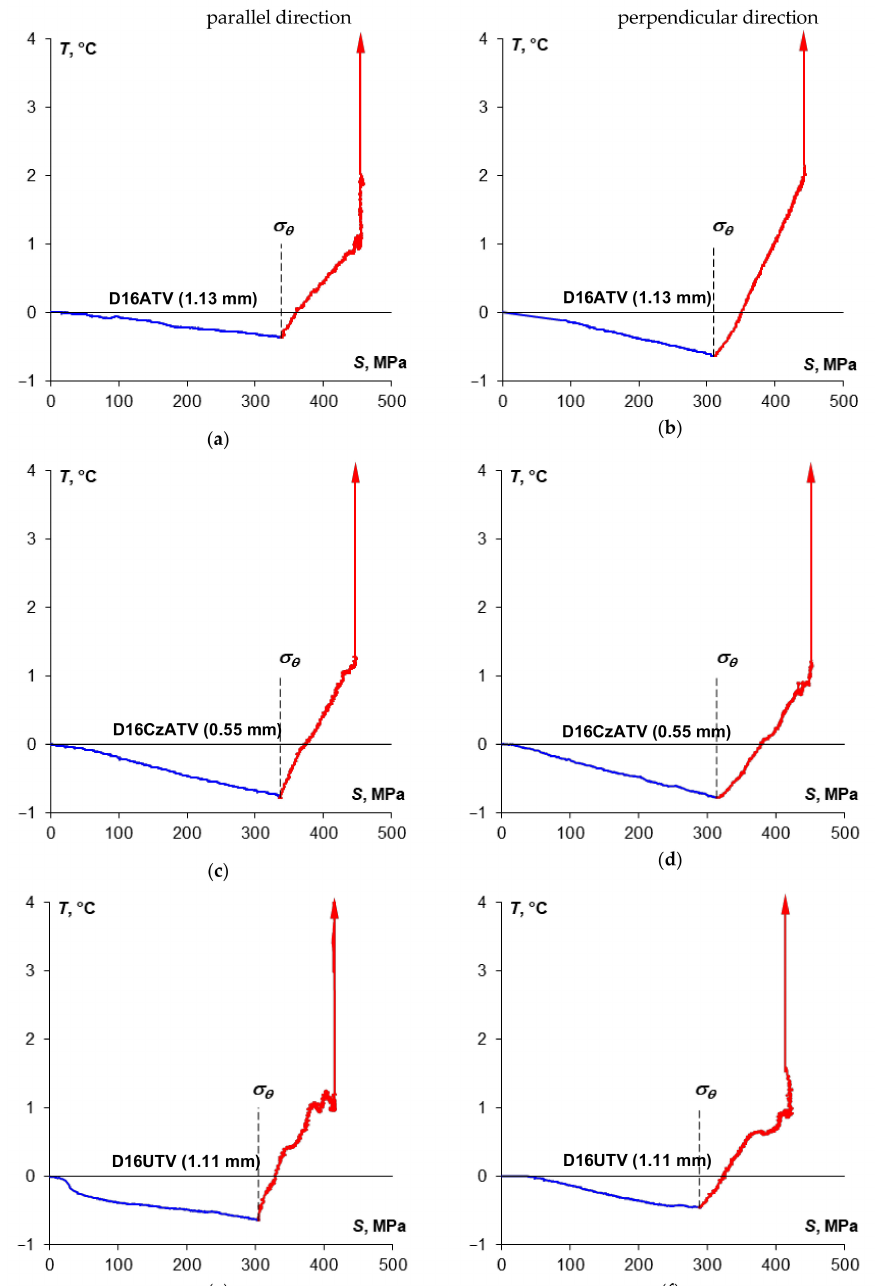
Figure 13. The summary of the temperature T and stress S change curves obtained during mono- tonic tensile tests of specimens made of D16ATV sheet plate ( a , b ), D16CzATV sheet plate ( c , d ) and D16UTV sheet plate ( e , f ) depending on the specimen cutting direction in relation to the sheet plate rolling